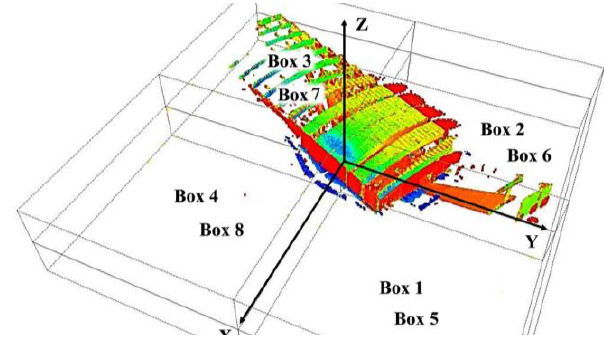
Figure 1. The point cloud separation by boundary boxes